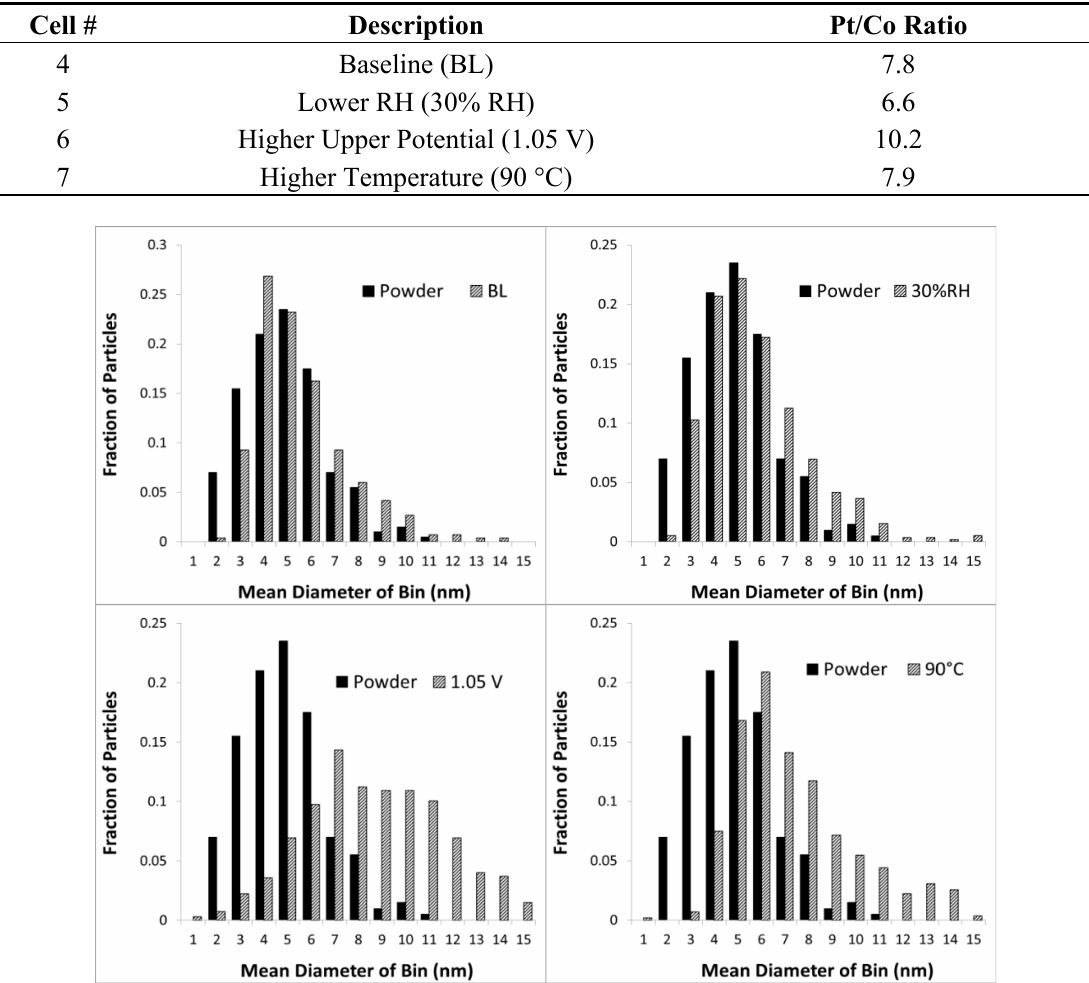
Figure 10. TEM analysis of Pt 3 Co particle size distributions of the pristine ( black ) and decayed catalysts ( hashed ) from parametric